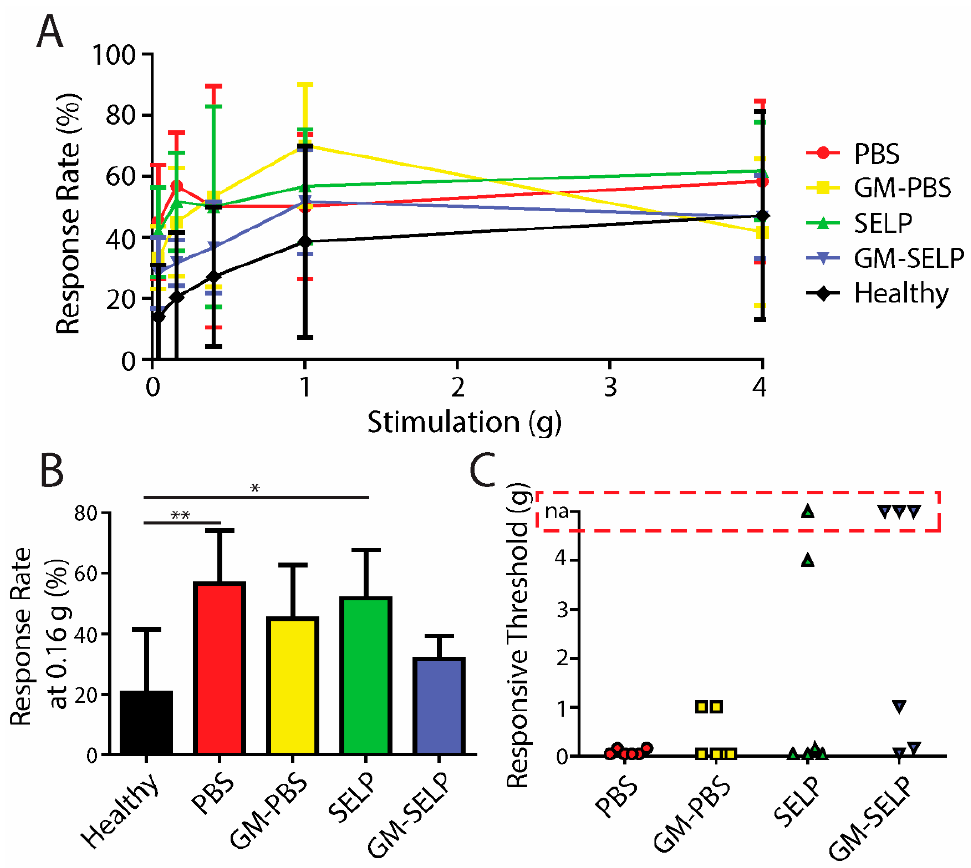
Figure 4. Behavioral pain responses at the time of sacrifice. ( A ) Response rates of irradiated animals receiving selected treatments and healthy controls. ( B ) Response rates with the 0.16-g filament. ( C ) Threshold required to elicit an allodynic response as measured by an increase in 30% from the baseline. Red box indicates animals with no allodynic response (na). (** p < 0.01, * p < 0.05).